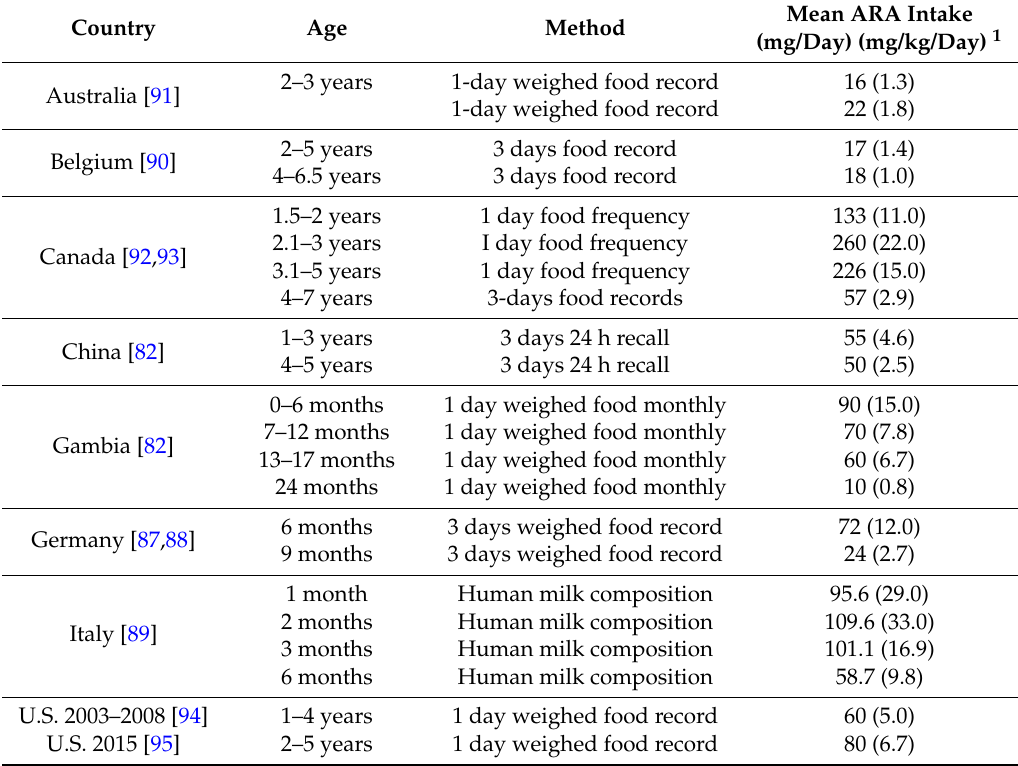
Table 1. ARA intakes in developed and developing countries during the first 2 years of life.